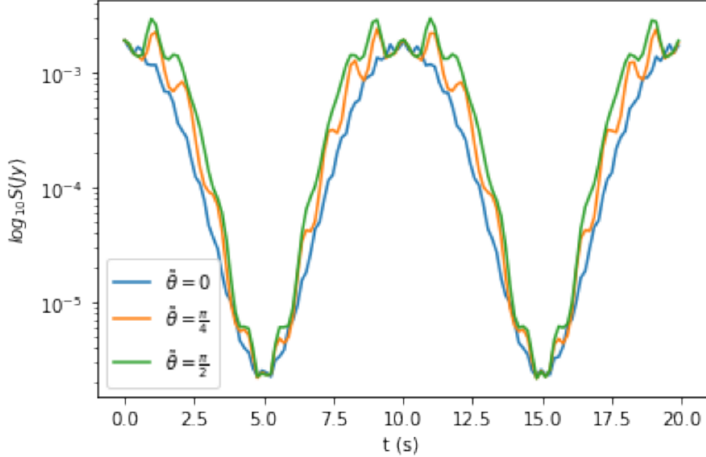
and ˜ θ = π respectively. 4 2